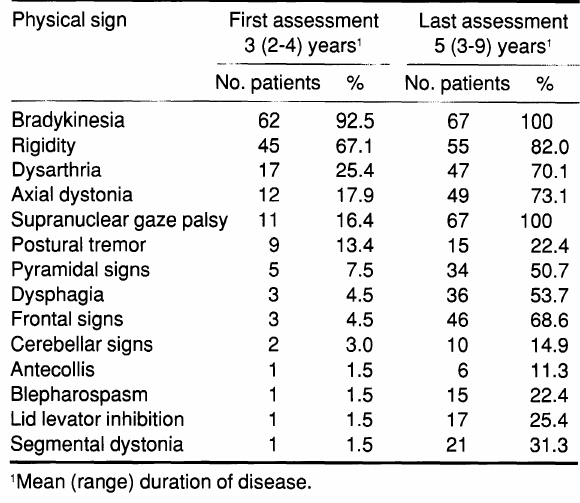
TABLE I. Initial presenting symptoms in 67 patients diagnosed as SROS Symptoms No. patients